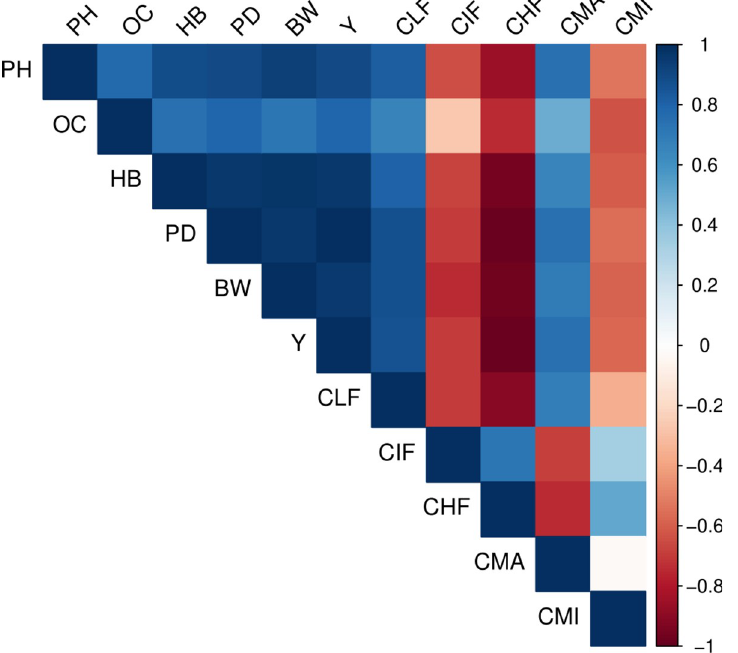
Fig 5. Heatmap of correlation coefficient among soil aggregates, size-fraction and content of organic carbon, and agronomic traits. Pearson correlation is showed between variables described in this study. Yield (Y), pseudostem diameter (PD), plant height (PH), number of hands per bunch (HB), bunch weight (BW), carbon content at light fraction (CLF), carbon content at intermediate fraction (CIF), carbon content at heavy fraction (CHF), carbon content at macroaggregates (CMA), carbon content at microaggregates (CMI).